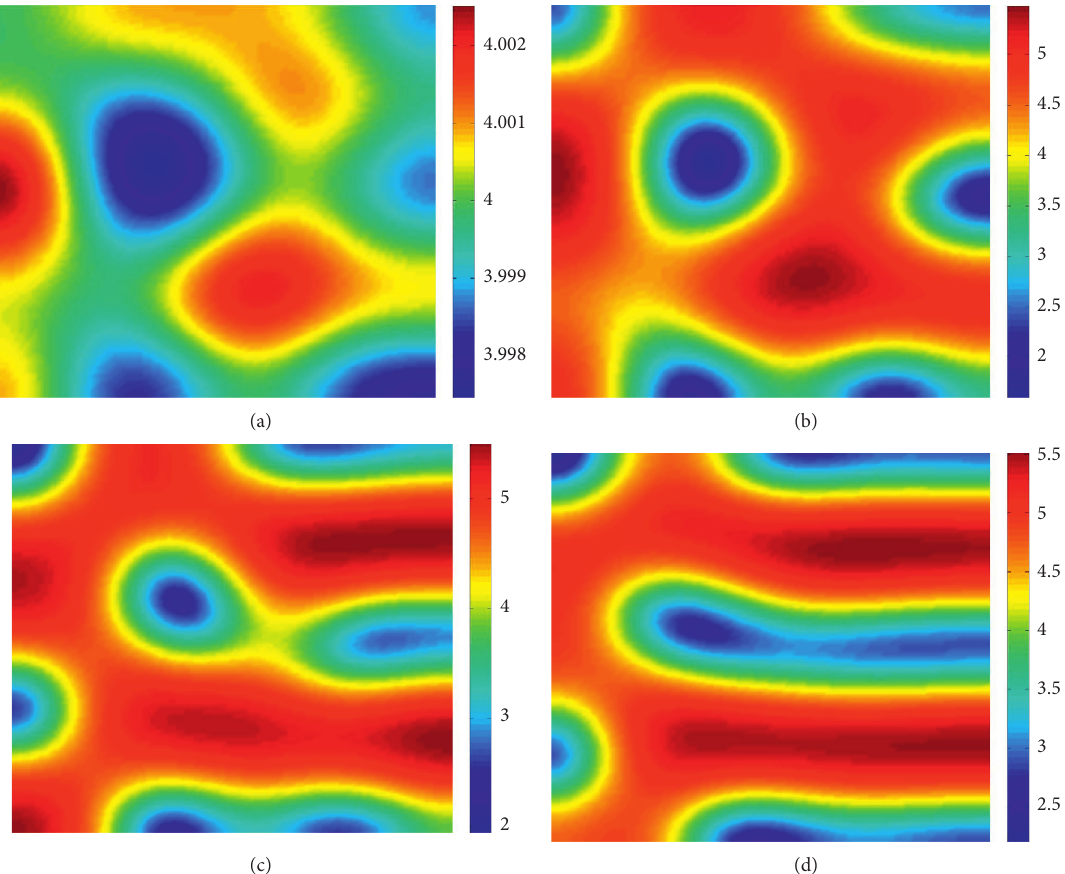
Figure 2: The spatial evolution of the density of the infected with time for time delay τ � 0 . 1: (a) t � 90000; (b) t � 200000; (c) t � 300000; (d) t �